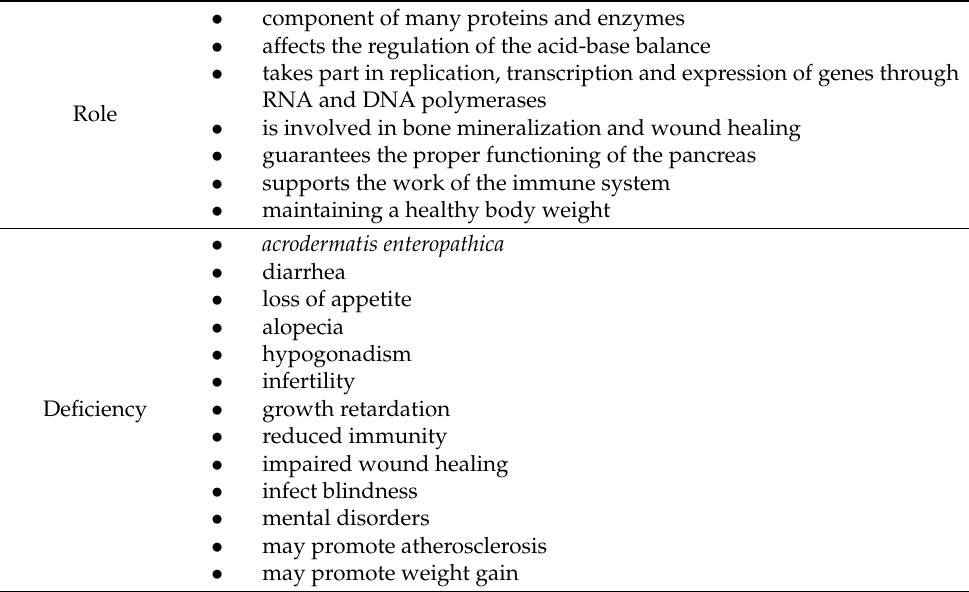
Table 2. Role of zinc in the human body and the effects of its deficiency and